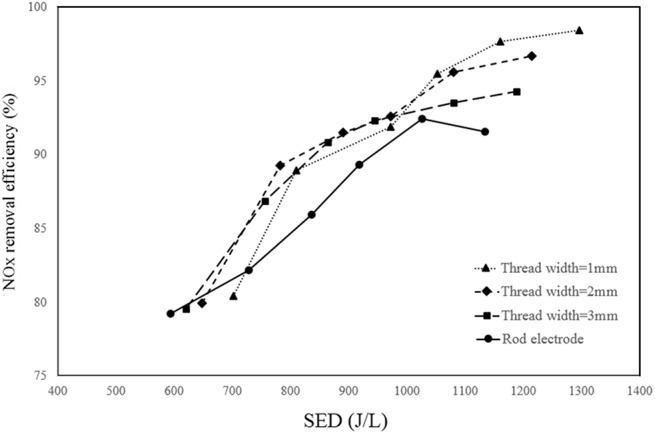
The variation of NOx removal efficiency as a function of SED for various studied electrodes at 9.9 kVPP.